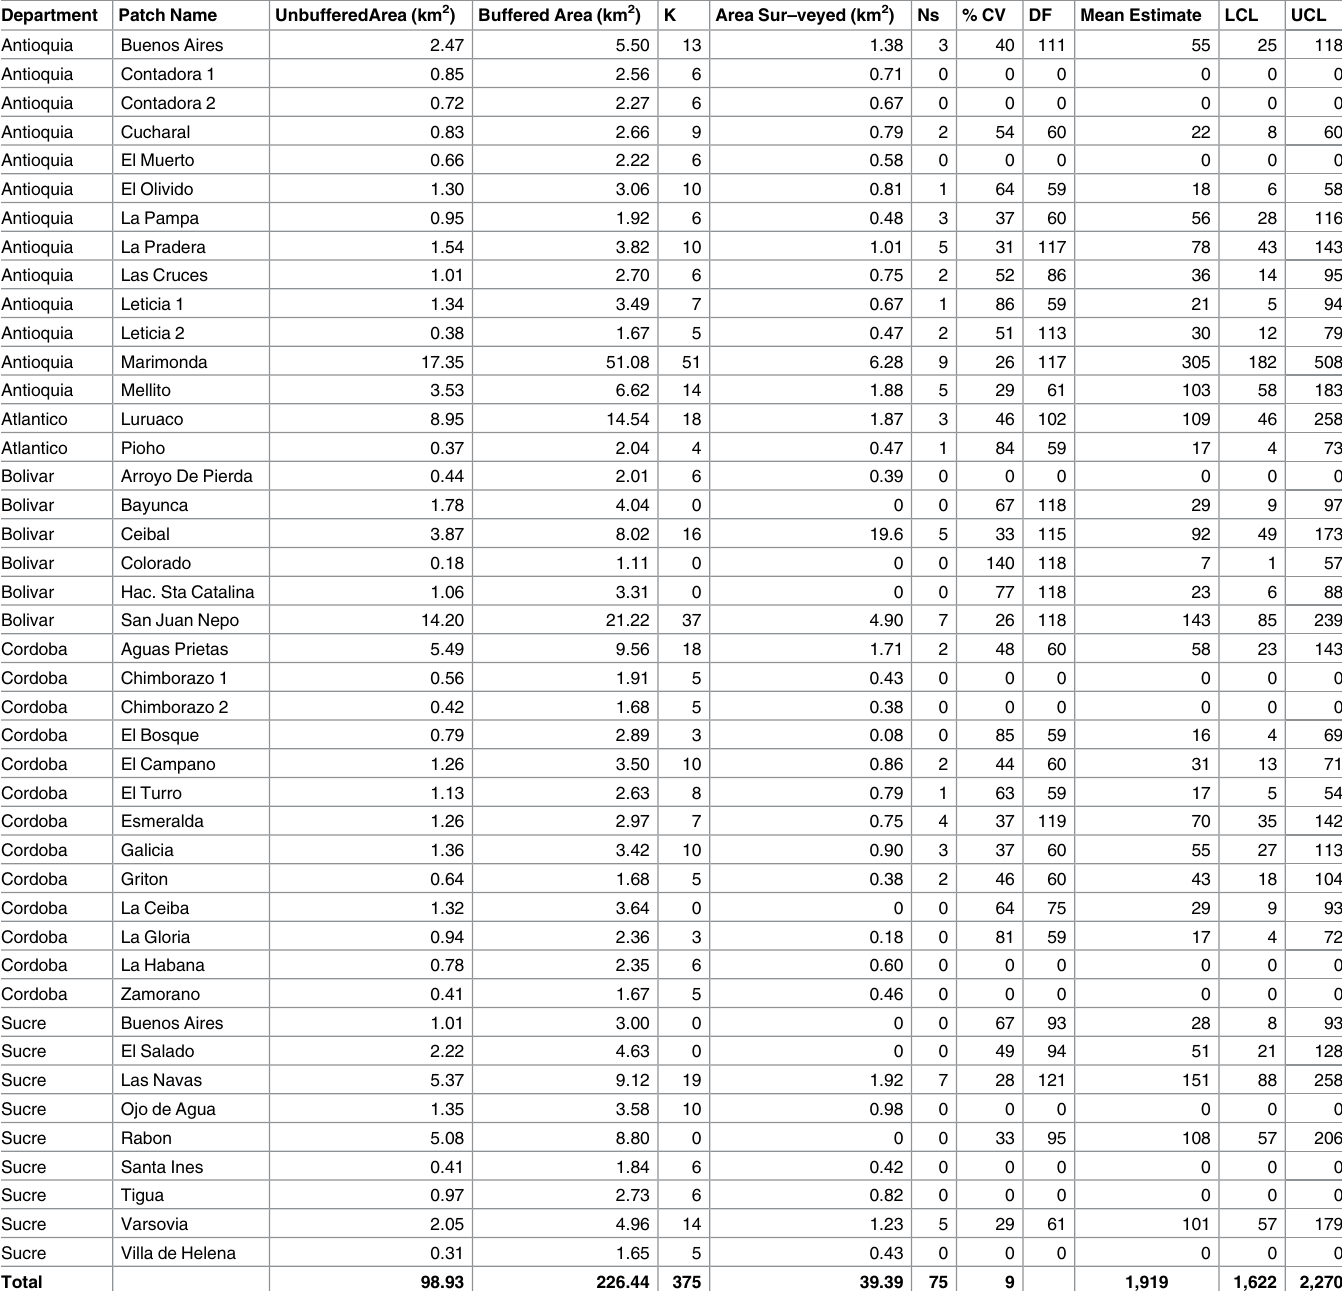
Table 2. Forest patches, cotton-top sightings, and estimated population size of surveyedareasin